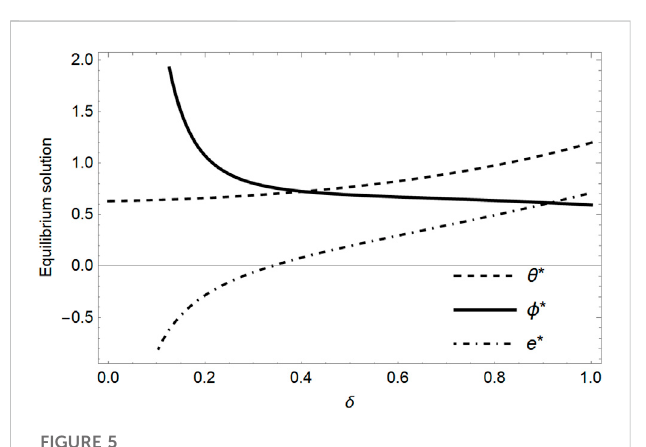
FIGURE 7 The impact of k m on the amount of growth in the manufacturer ’ s expected